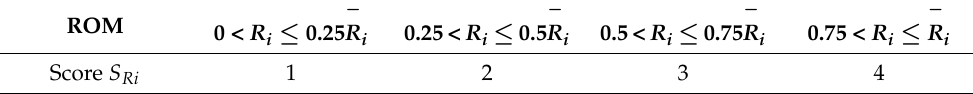
Table 3. ROM rating scale of finger.